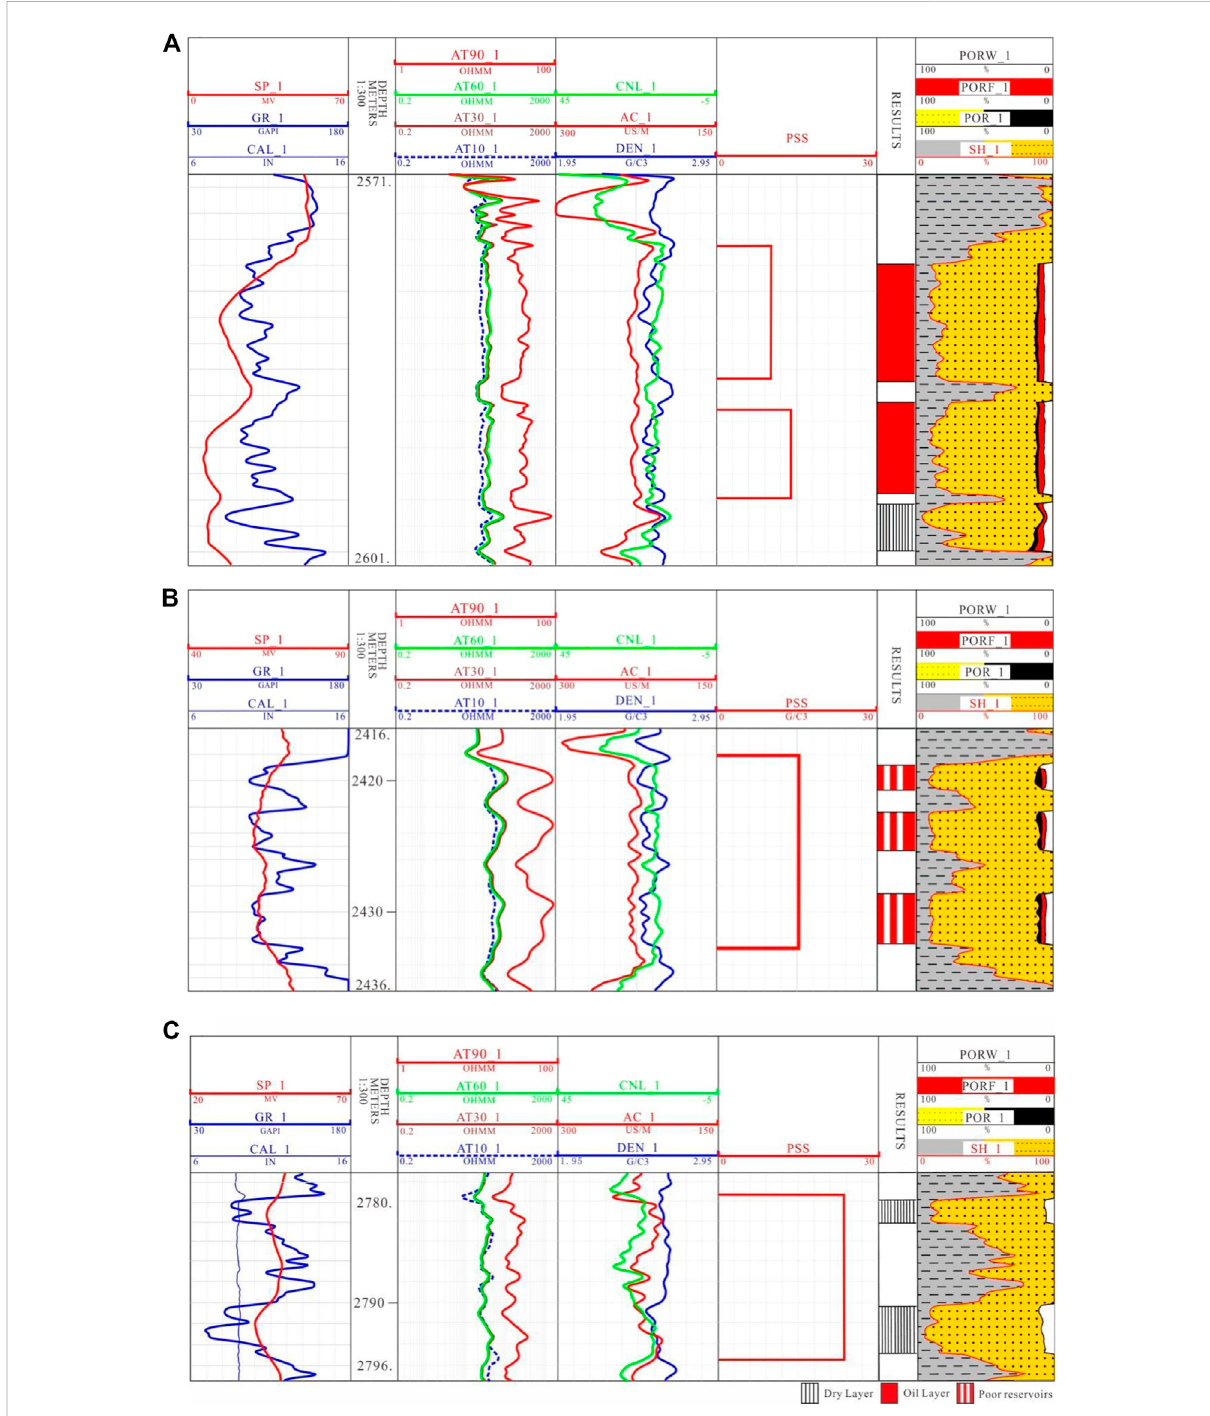
FIGURE 8 Evaluation of the classi fi cation of tight oil layers in typical wells in the study area. (A) Well L38; (B) Well B35; (C) Well